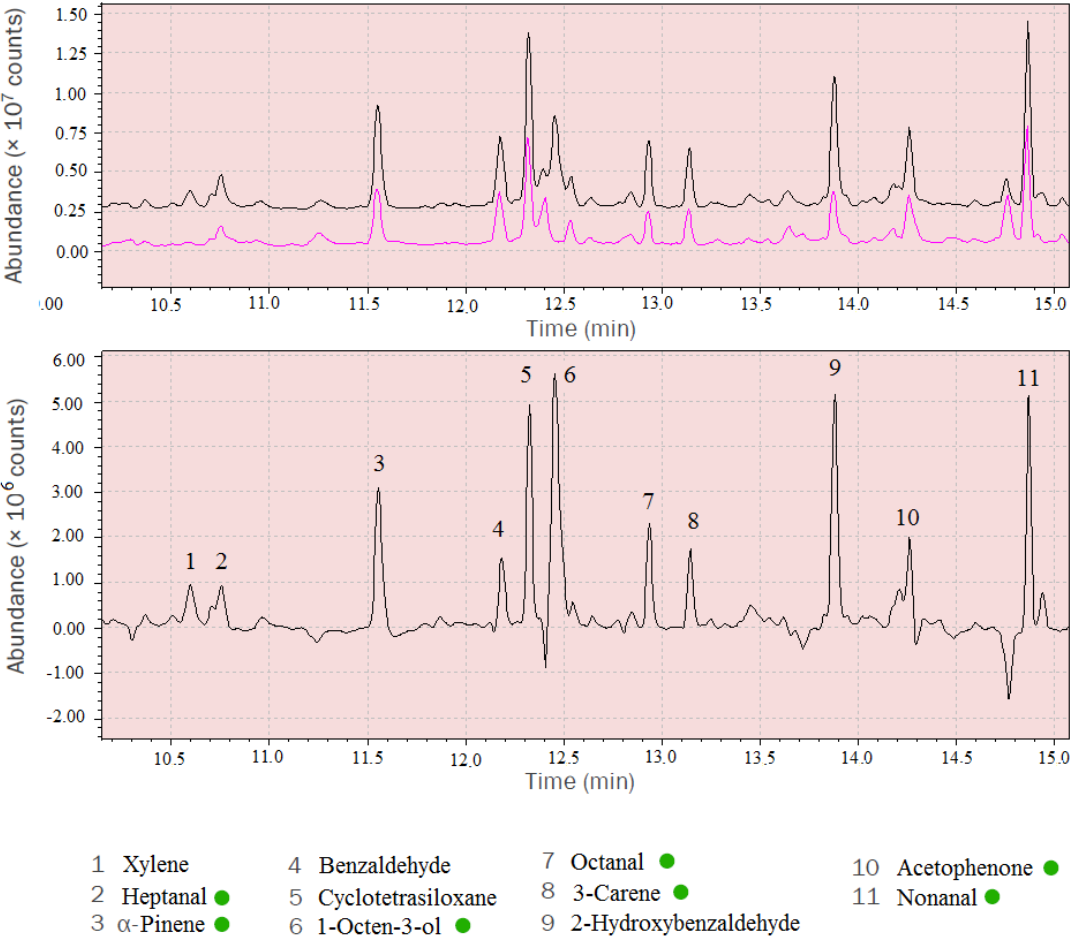
Figure 3. Comparison of control chamber spectrum (red) with experimental chamber (black) ( A ) and the subtracted mass spectrum with identified compounds ( B ). MVOCs are marked by green dots. Table 1. Overview showing the range of MVOC levels emitted by Coniophora puteana and Poria placenta after one day, two weeks and one month of